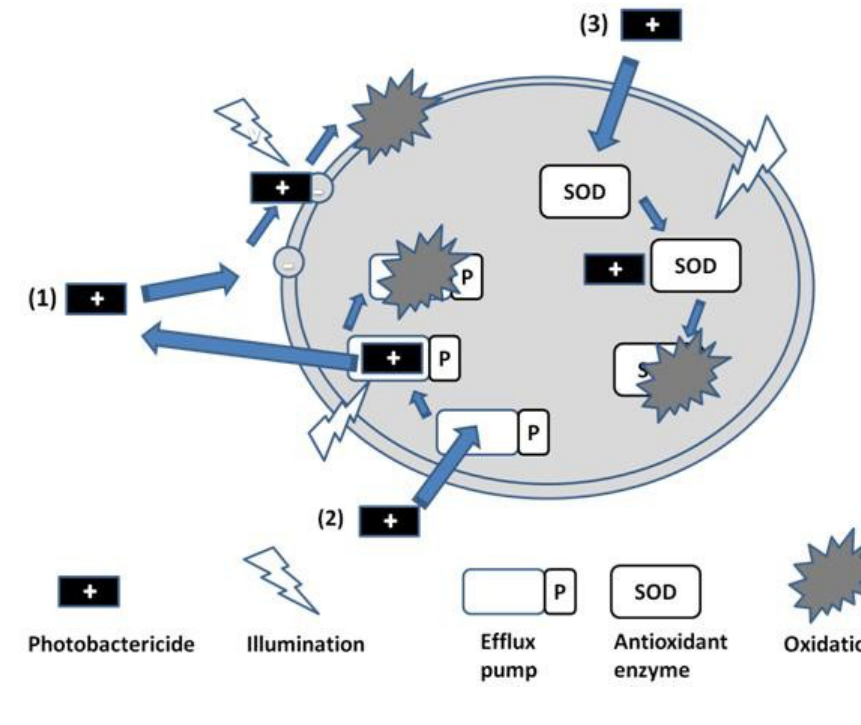
Figure 3. Photobactericide action and resistance